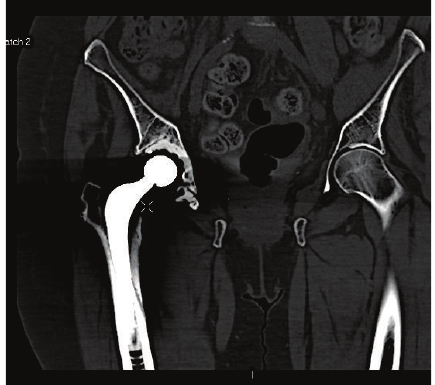
Figure 1: Radionuclide bone scan showing increased activity in right femoral shaft.